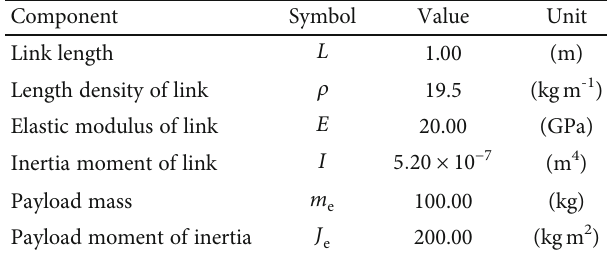
Table 1: Physical parameters of the fl exible single-link manipulator for